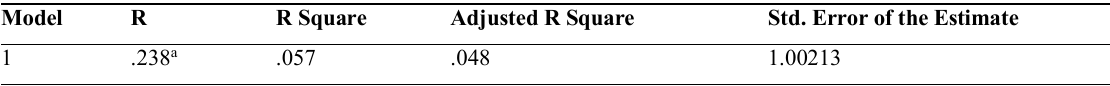
Table 3: Model Summary for Loan Pricing Practices